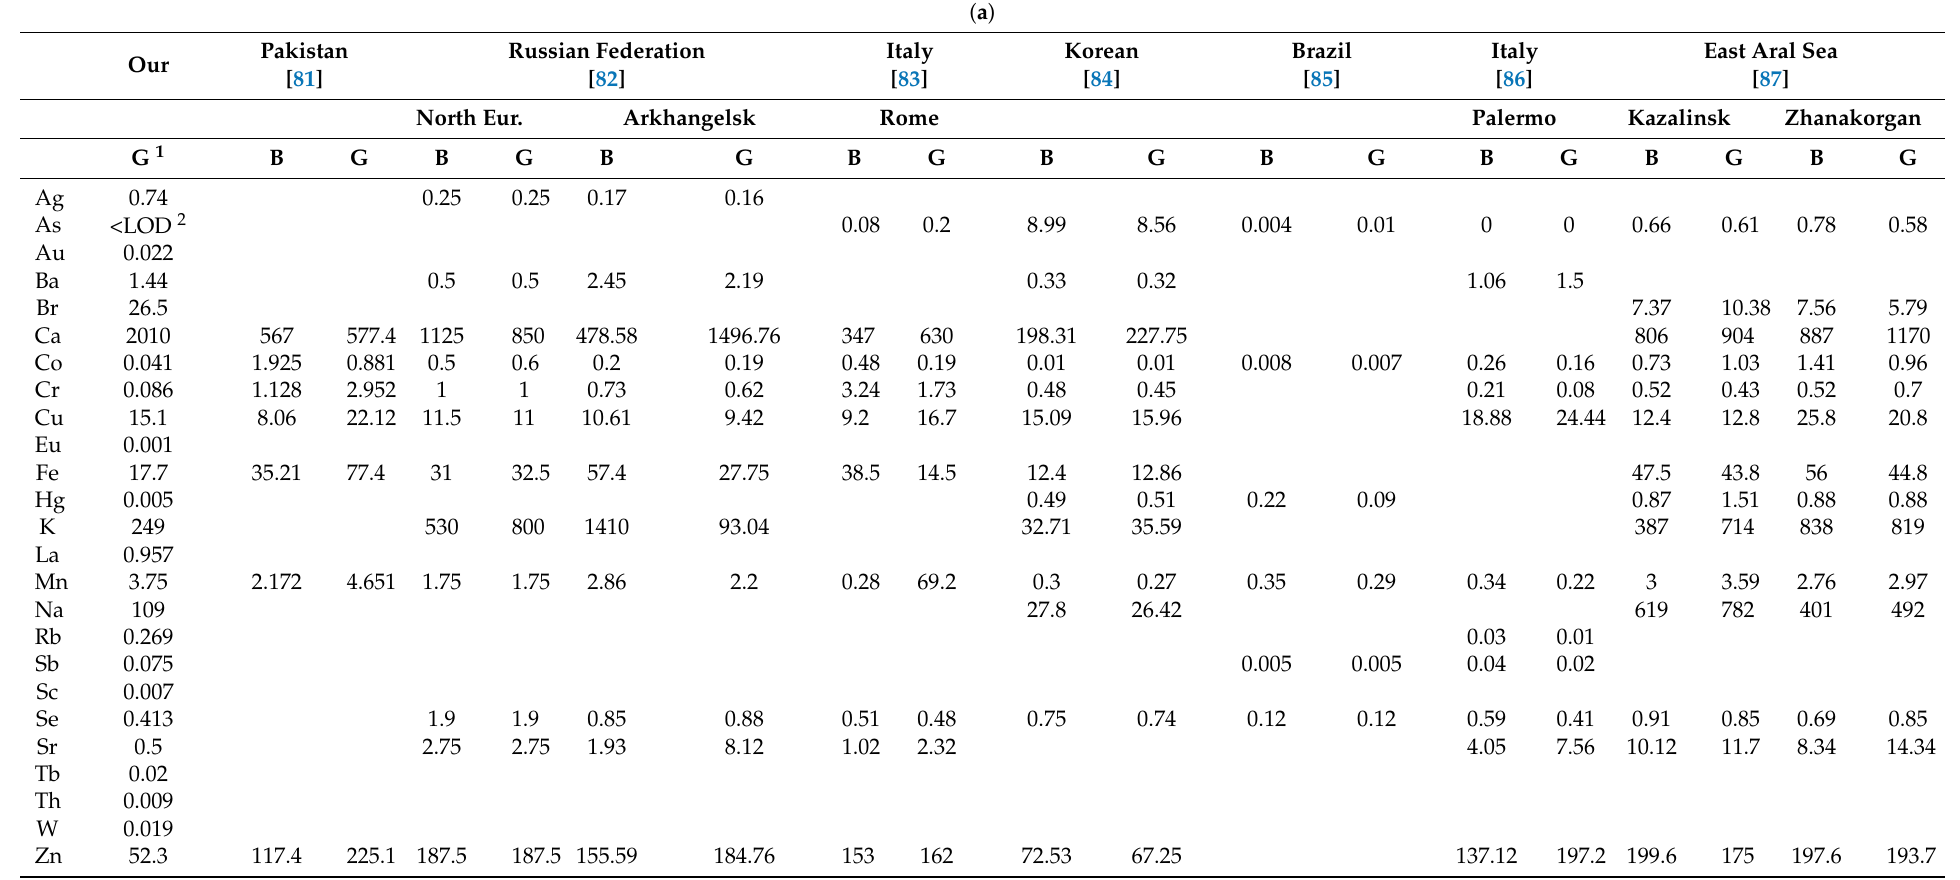
Table 5. Comparison of element levels ( µ g g − 1 ) found in hair samples of teenagers worldwide. ( a